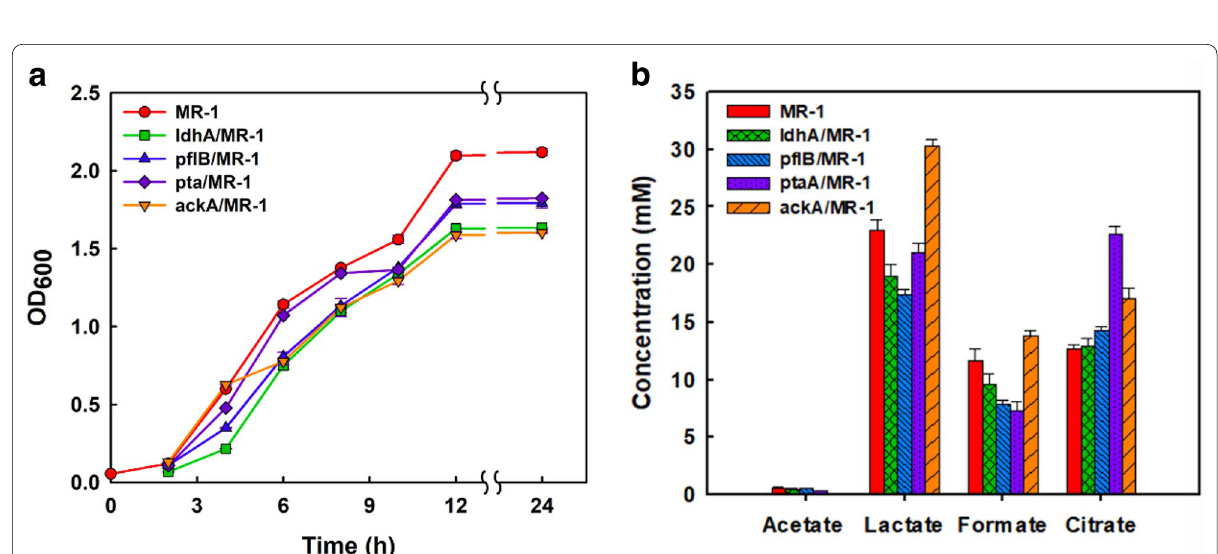
Fig. 2 Characterization of Shewanella strains via single downregulation of different genes. a Growth curve compared to wild‑type MR‑1 in LB. b Metabolites were analyzed by HPLC at 12 h. The genes repressed in MR‑1 are